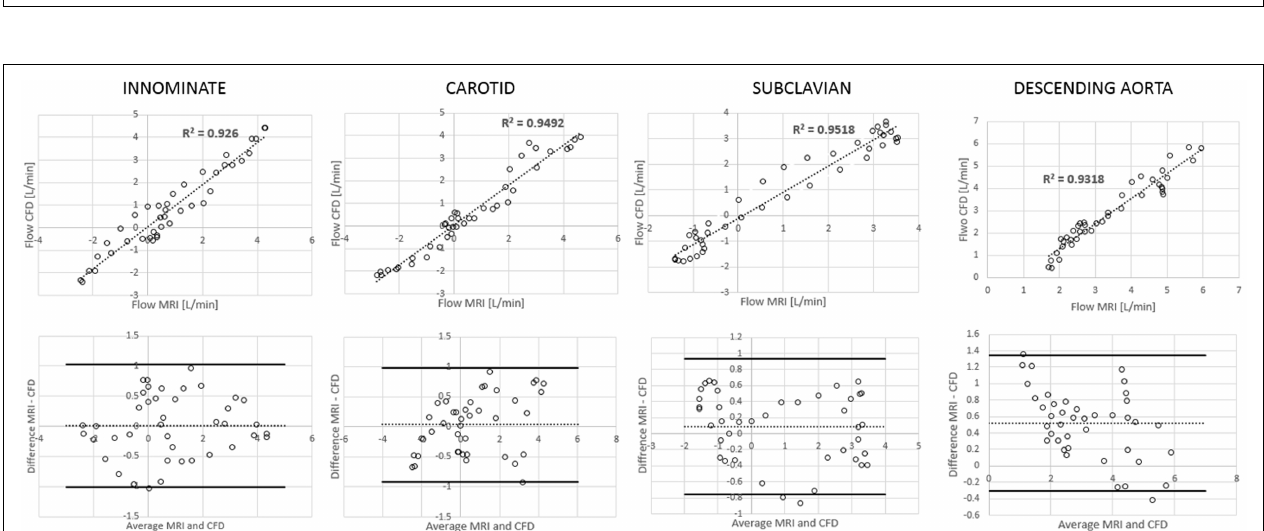
FIGURE 6 | Correlation and Bland Altman plots for flow measurements (CMR vs. CFD) at four locations in the control model .